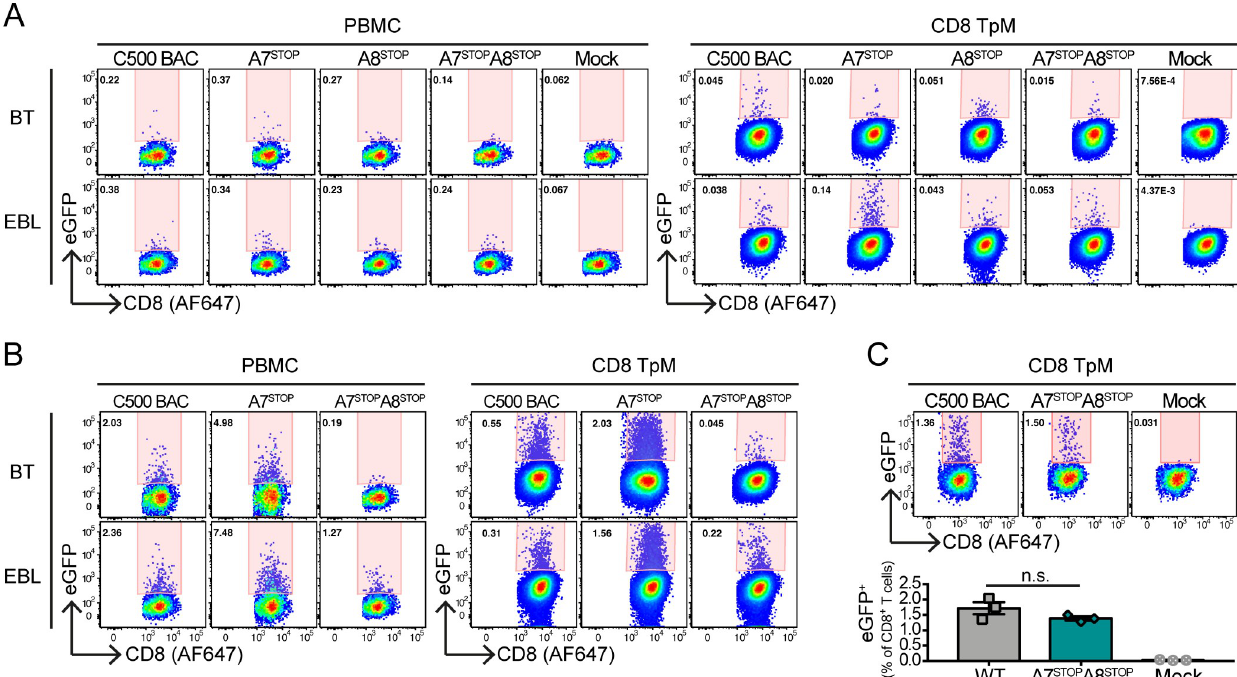
Fig 10. Ex vivo infection of bovine CD8 + T lymphocytes by co-culture with infected BT or EBL cell. (A and B) Pseudocolour contour plots showing the percentages of eGFP + cells in gated CD8 + T lymphocytes (PBMCs or CD8TpM cell line) by flow cytometry after 48h co-culture with BT or EBL infected with C500 BAC + WT, BAC + A7 STOP , BAC + A8 STOP or BAC + A7 STOP A8 STOP viruses (A = m.o.i. = 0.01; B = m.o.i. = 0.1). (C) Representative pseudocolour contour plots of CD8TpM cells showing the percentages of eGFP + cells after co-culture with EBL infected with C500 BAC + WT or BAC + A7 STOP A8 STOP virus. Bars show mean ± SD (n = 3). One-way ANOVA with Dunnet’s post-hoc test was used to identify significant differences (n.s. = not significant).